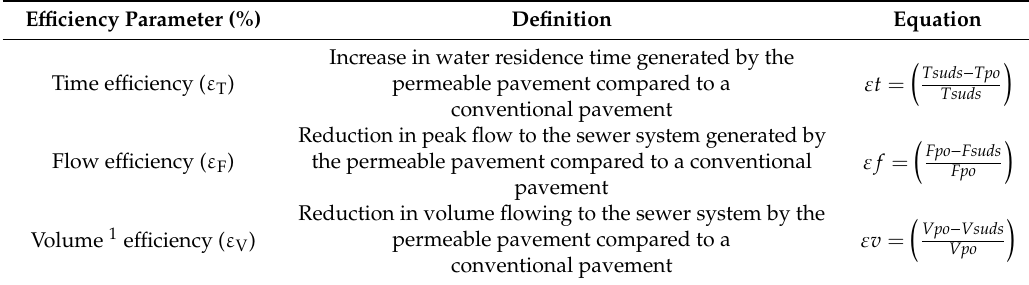
Table 4. Definition of e ffi ciency